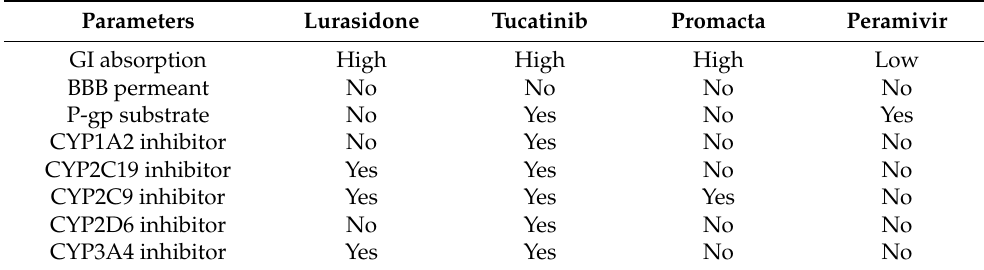
Table 3. Comparative pharmacokinetics analyses.